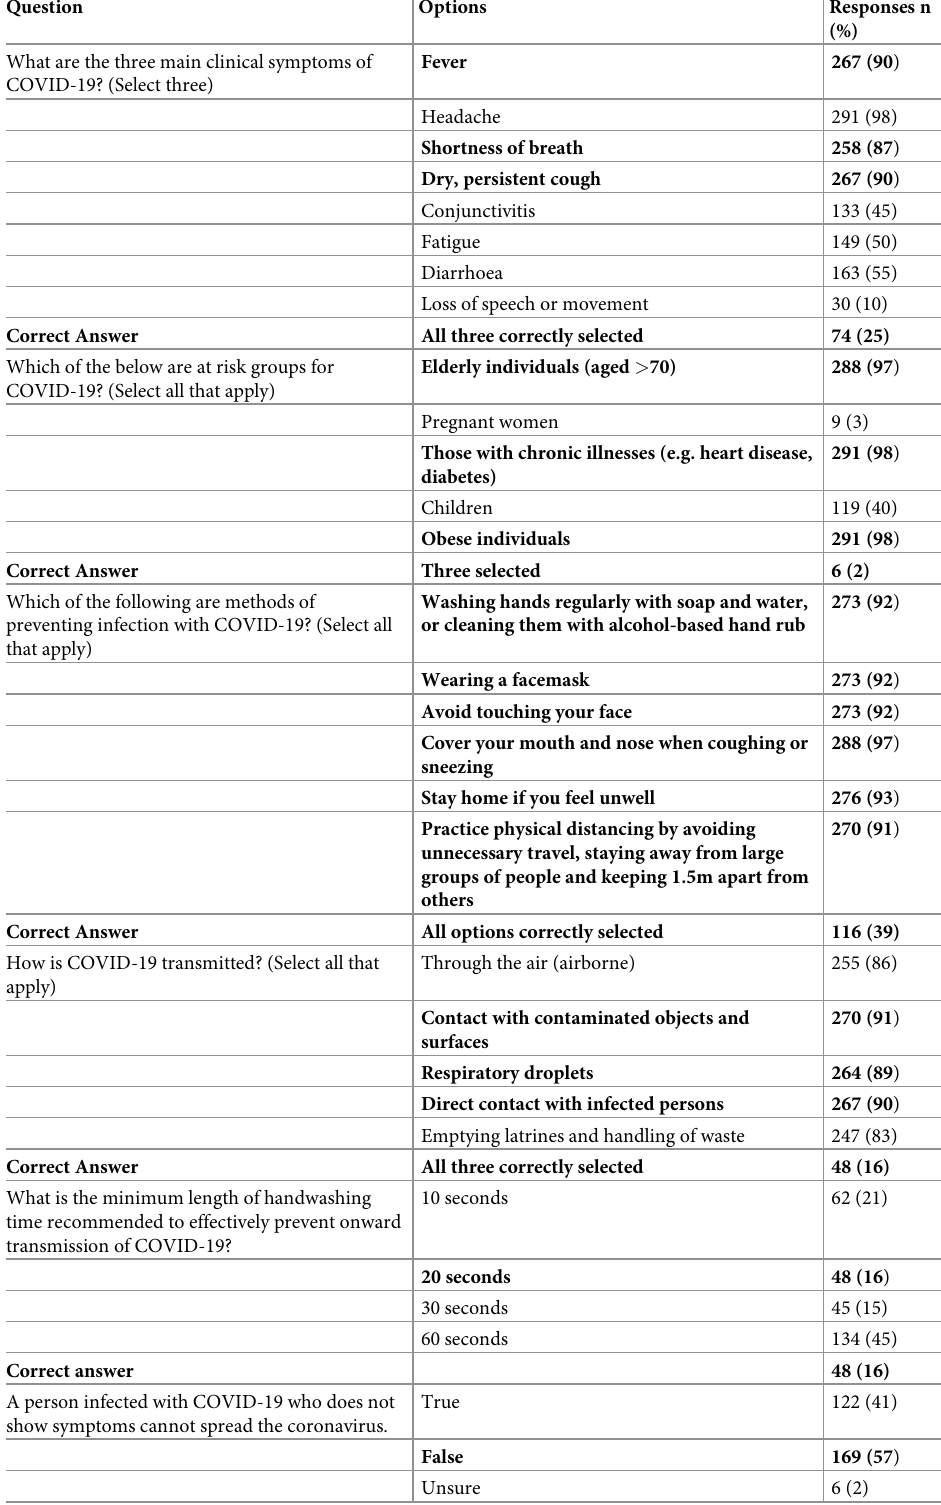
Table 3. General knowledge of COVID-19 among respondent APES (N =